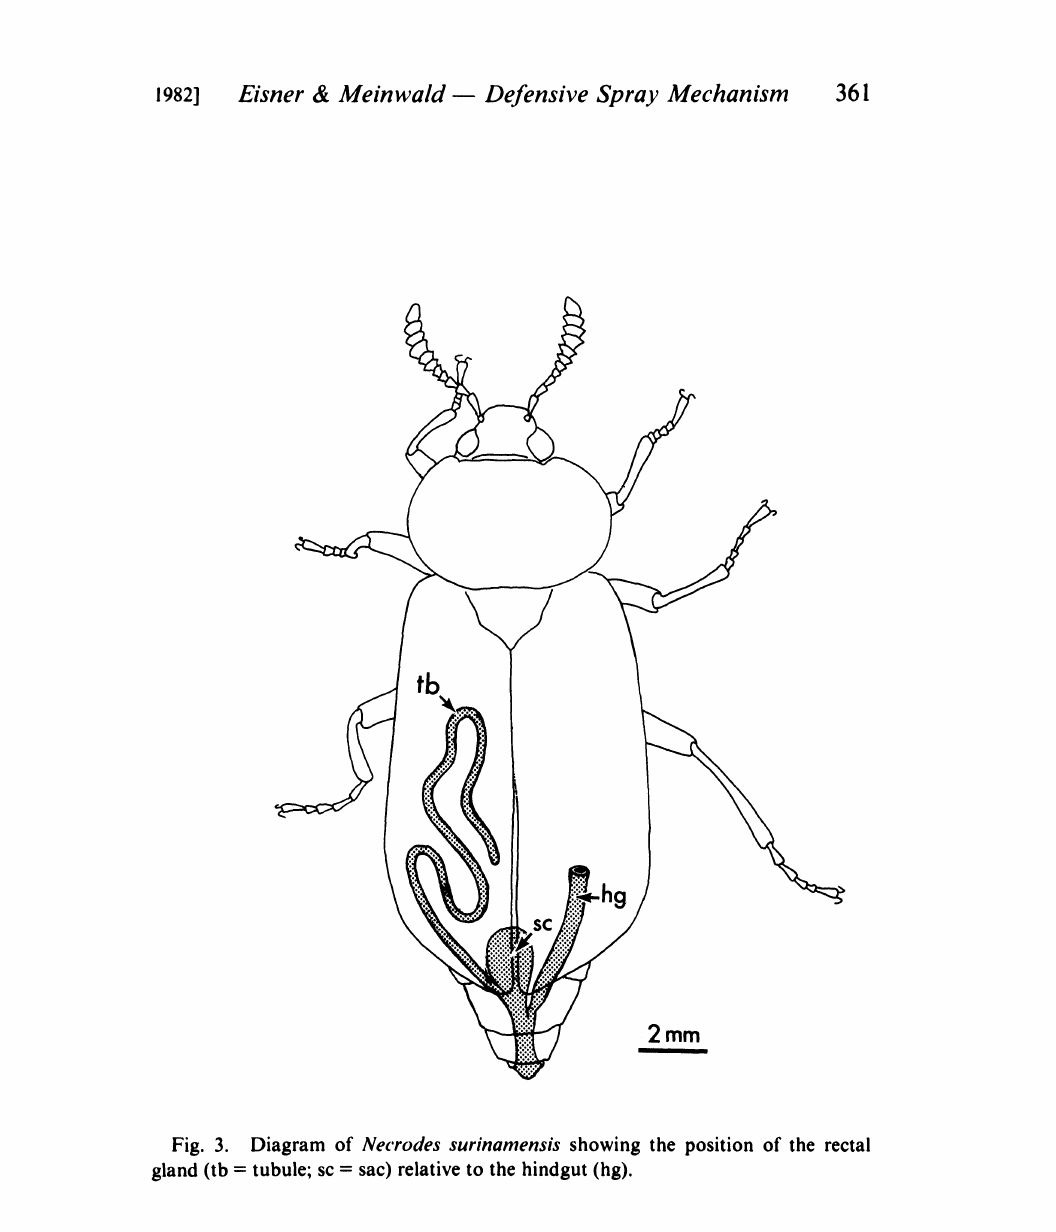
Fig. 3. Diagram of Necrodes surinamensis showing the position of the rectal gland (tb tubule; sc sac) relative to the hindgut